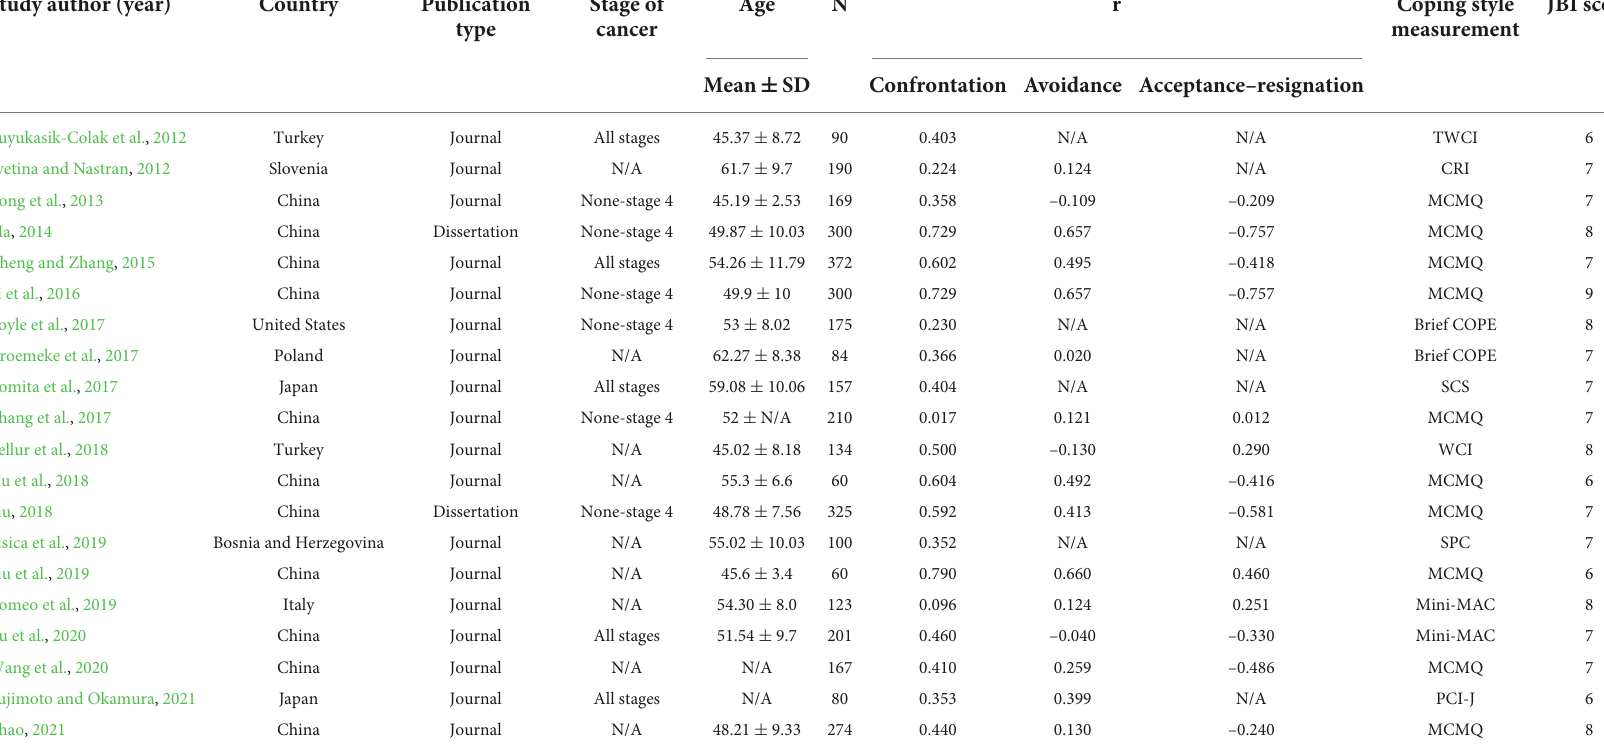
TABLE 1 Characteristics of the 20 studies involved in this